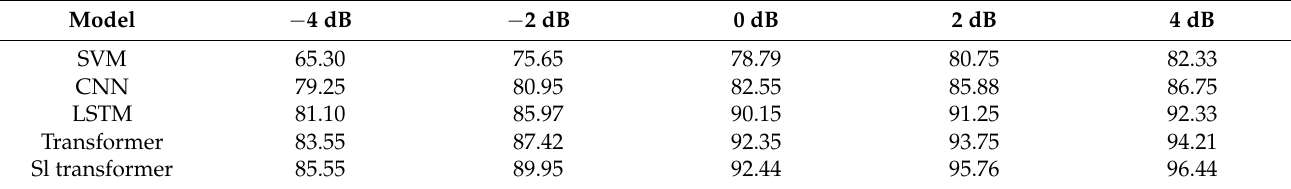
Table 5. The accuracy table of applying SSA algorithm.